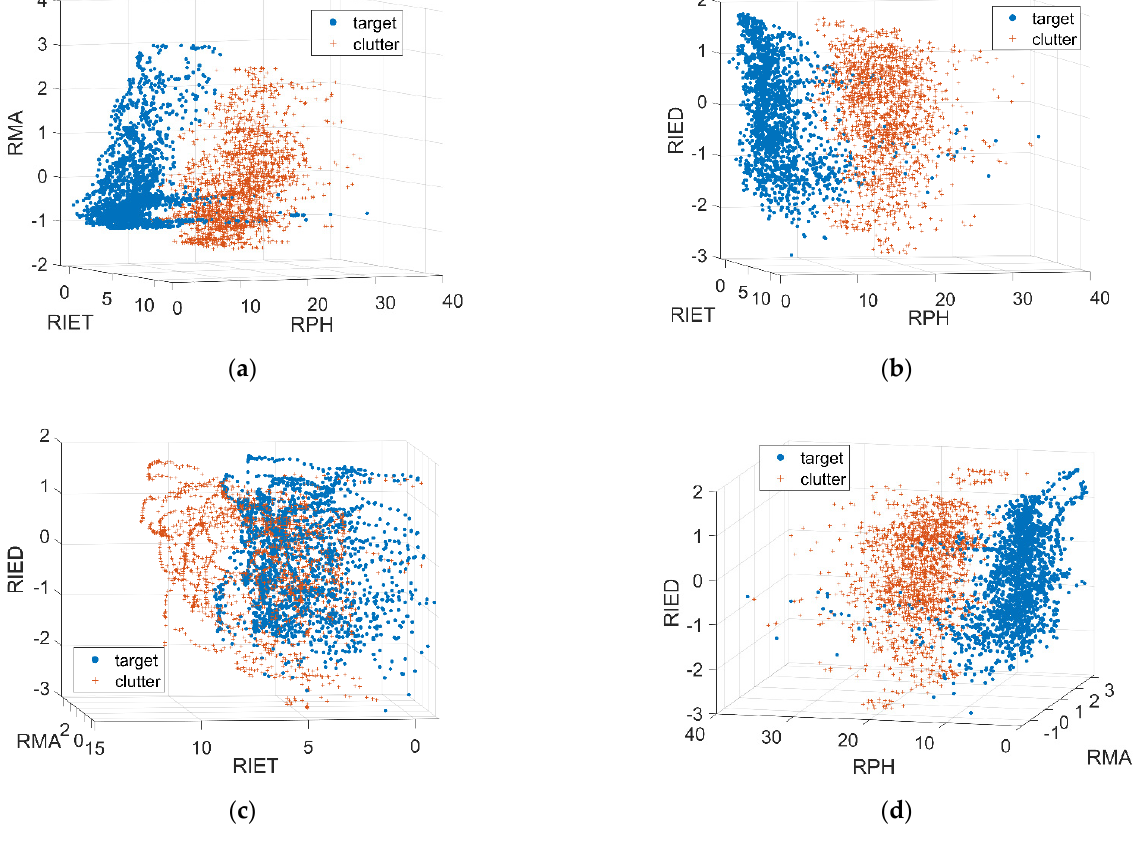
Figure 12. Representation of three-dimensional characteristics on targets and clutter. ( a ) RMA—RPH—RIET; ( b ) RPH— RIET—RIED; ( c ) RIET—RMA—RIED; ( d ) RPH—RMA—RIED.